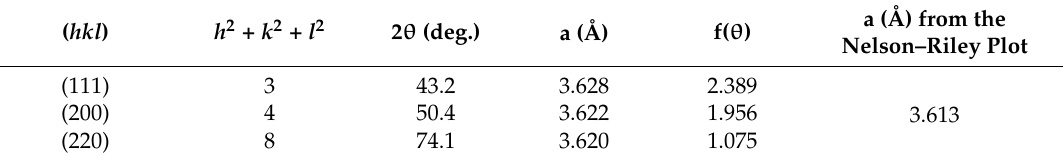
Table 4. Structural parameters of Cu in nanocomposite A with 20 vol % of TiC sintered at 900 ◦ C.